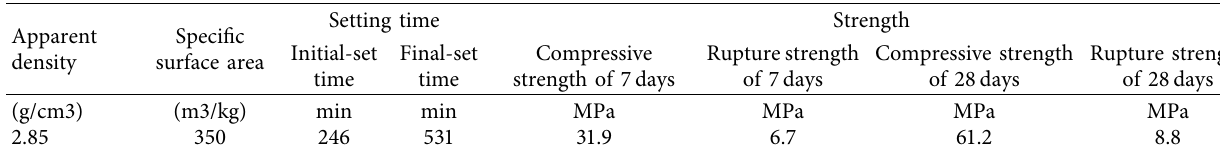
Table 3: Technical Indexes of Curing